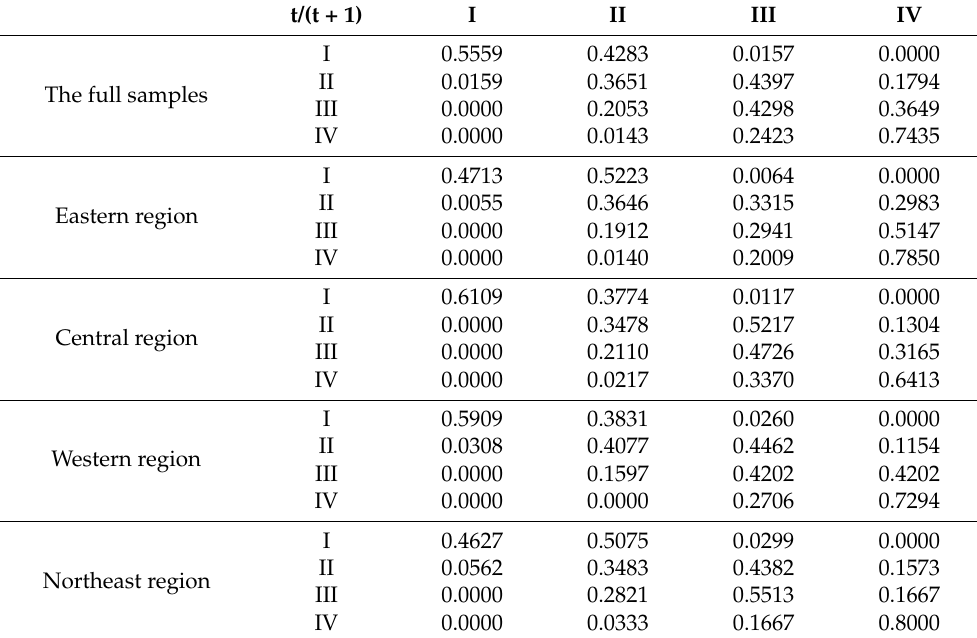
Table 4. Markov transition probability matrices of CD&GDD of whole sample and subregions from 2011 to